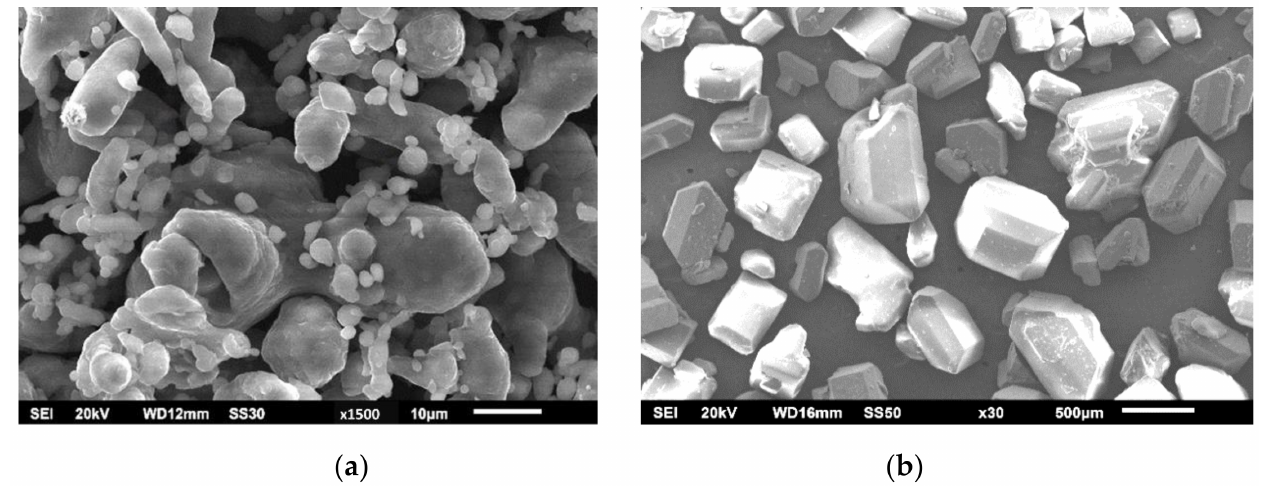
Figure 1. SEM micrographs of ( a ) pure aluminium powder ( × 1500) and ( b ) saccharose particles ( ×